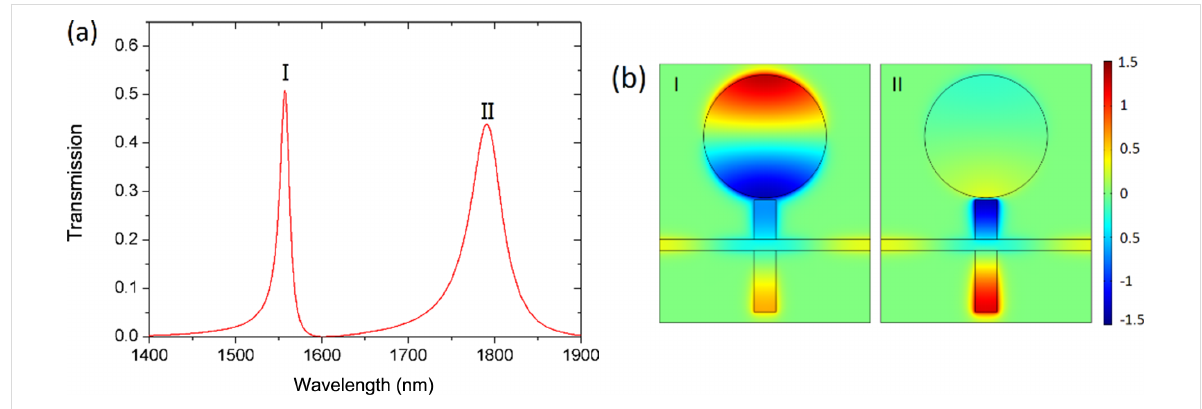
Figure 3: (a) Transmission spectra of the entire structure. (b) H z field patterns at the peak wavelengths of the two resonances. The radius of the disk is R = 280 nm. The lengths of the stubs are L 1 = 180 nm, L 2 = 280 nm.